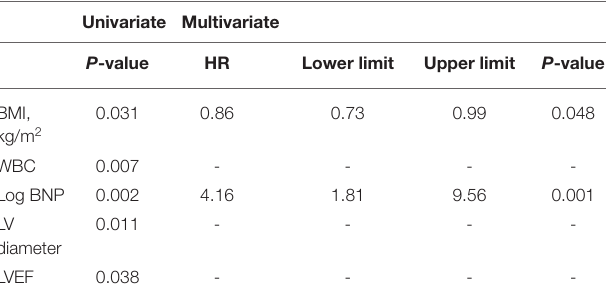
TABLE 2 | Backward conditional Cox univariate and multivariate analysis for all-cause mortality. Univariate